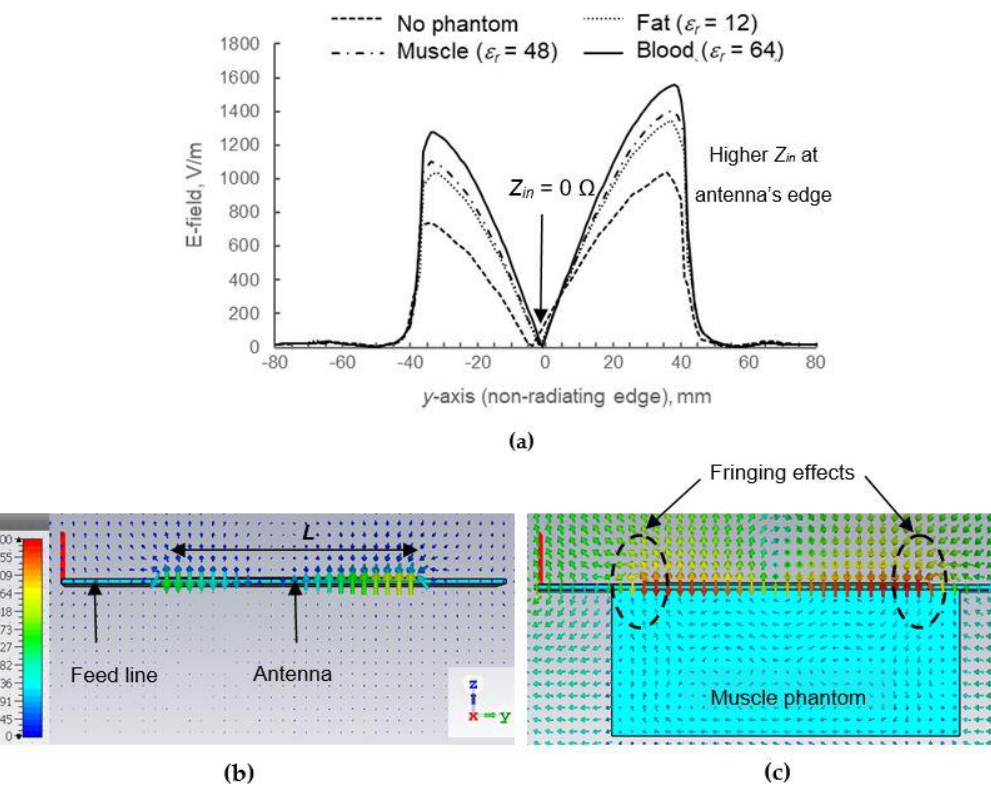
Figure 15. Near-field electric field intensity: ( a ) Distribution graph along y -axis (non-radiating edge); ( b ) 3D view (without phantom); ( c ) 3D view (with muscle phantom, ε r = 48).